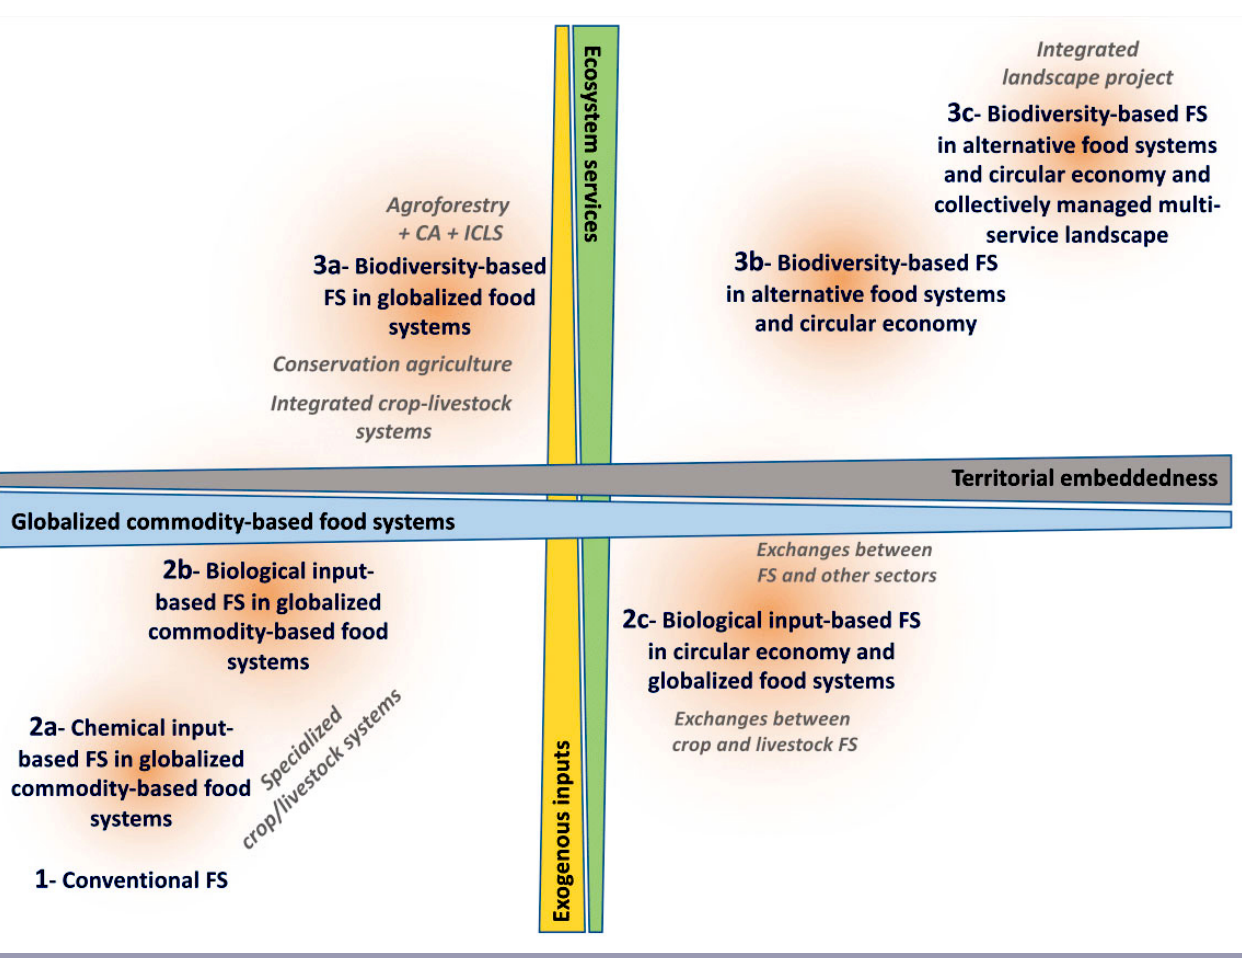
Fig. 2 . Main models of agriculture (from 1 to 3b in blue) with farming systems identified based on their varying degrees of use of ecosystem services versus anthropogenic exogenous inputs (Y-axis) and connected to globalized food systems or local dynamics (X- axis). Iconic examples are presented in grey. The number 1 is for conventional farming systems outside less-favored areas (1 being the current, conventional agriculture model). The main alternative agriculture models were grouped into two types of alternatives to reflect the paradigm shift between input-based (type-2) versus biodiversity-based farming systems (type-3). Submodels labeled a, b, and c mainly reflect the relationships between farming systems, globalized food systems, and local dynamics. (CA:conservation agriculture; FS:farming system; ICLS:integrated crop livestock